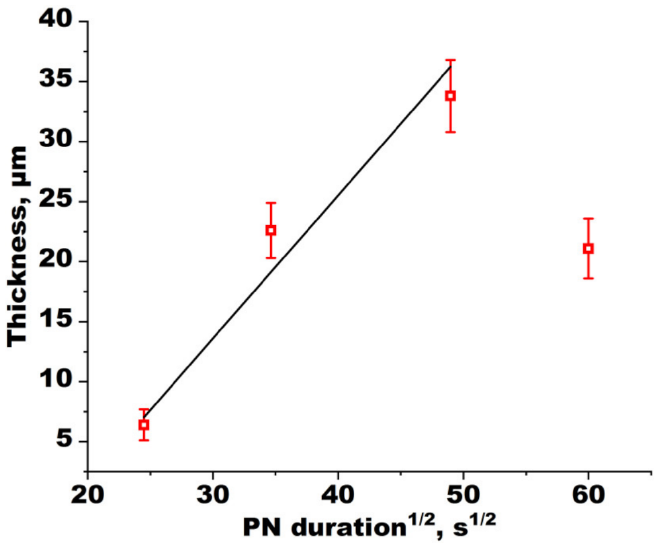
Figure 12. Thickness of the nitrided layer of AISI 420 steel samples as a function of the PN